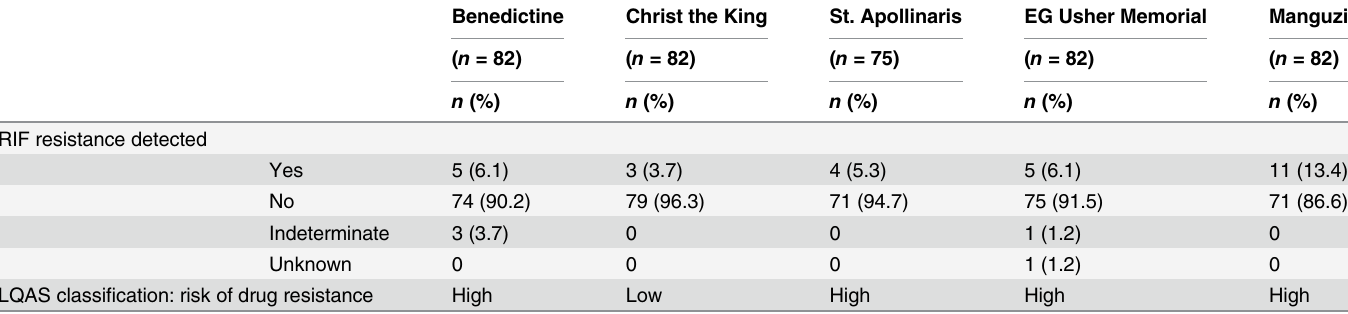
Table 6. LQAS classifications: retrospective sites (n =